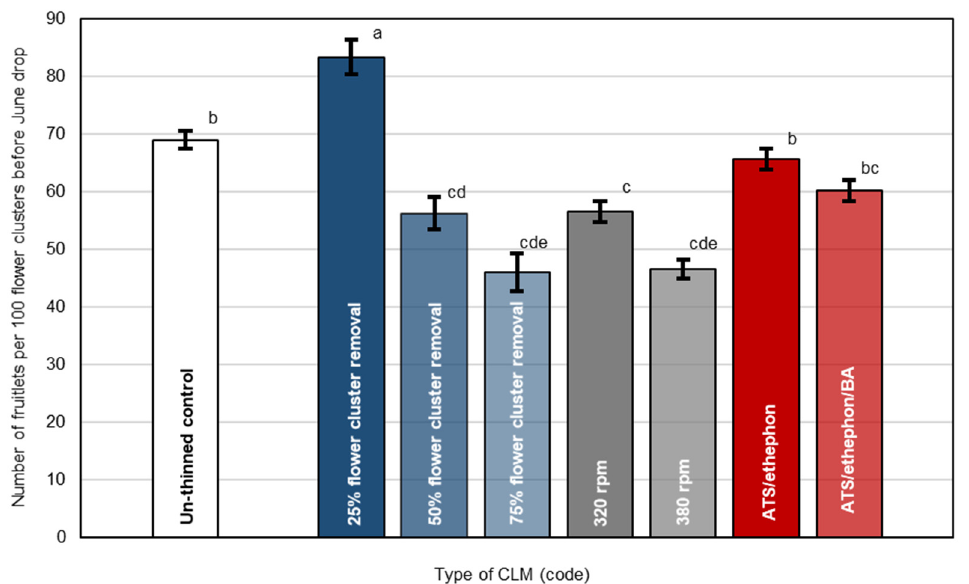
Figure 3. Effect of practical thinning methods on number of apple fruitlets before June drop per 100 flower clusters (white, un-thinned control; blue, thinning by hand at flowering; gray, mechanical blossom thinning; red, chemical thinning) (different letters denote statistically significant differences at the 5% level).